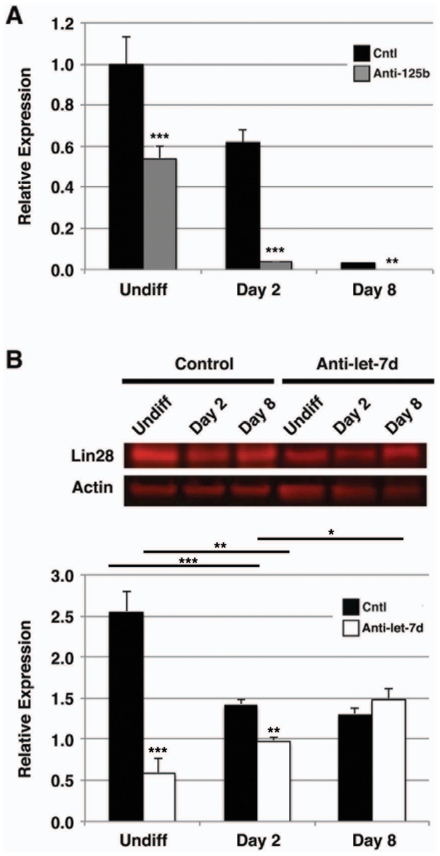
Lin28-mediated let-7d expression is regulated by miR-125b in differentiating hESCs.Untransfected hESCs (Cntl) or hESCs transfected with anti-miR-125b (anti-125b) or anti-let-7d (anti-let-7d) inhibitor were cultured in differentiation medium for 2 or 8 days. A) Cells were analyzed for expression of let-7d by qPCR. Inhibition of miR-125b downregulated expression of let-7d in both undifferentiated and differentiating hESCs. Data shown are mean±s.e.m. (N = 3). **, p<0.01; ***, p<0.001. B) Cell lysates were assayed for Lin28 by immunoblot analysis compared to undifferentiated cells (Undiff). Lin28 protein expression was noticeably decreased in undifferentiated hESCs transfected with anti-let-7d compared to untransfected undifferentiated cells. This effect was seen to a lesser extent in hESCs differentiated for 2 days. However, the effect of let-7d inhibition on Lin28 was lost by day 8 of differentiation (TOP). Actin was used as a loading control. Representative results are shown. Quantitation of fluorescent signals is shown (BOTTOM). Data shown are mean±s.e.m. (N = 3). *, p<0.05; **, p<0.01; ***, p<0.001.